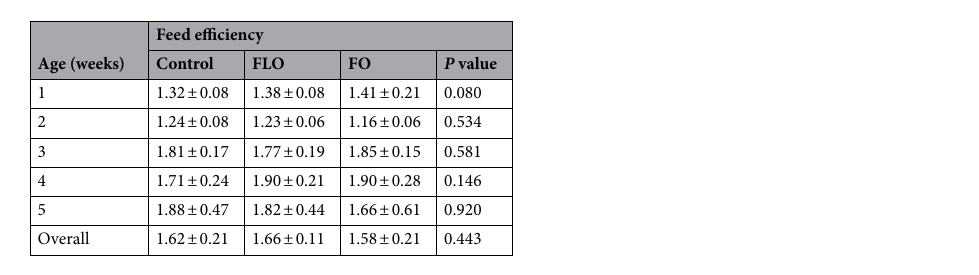
Table 3. The effects of different supplemental oils on the feed efficiency at different ages of broilers. Values are means ± SD. FLO flaxseed oil, FO fish oil.